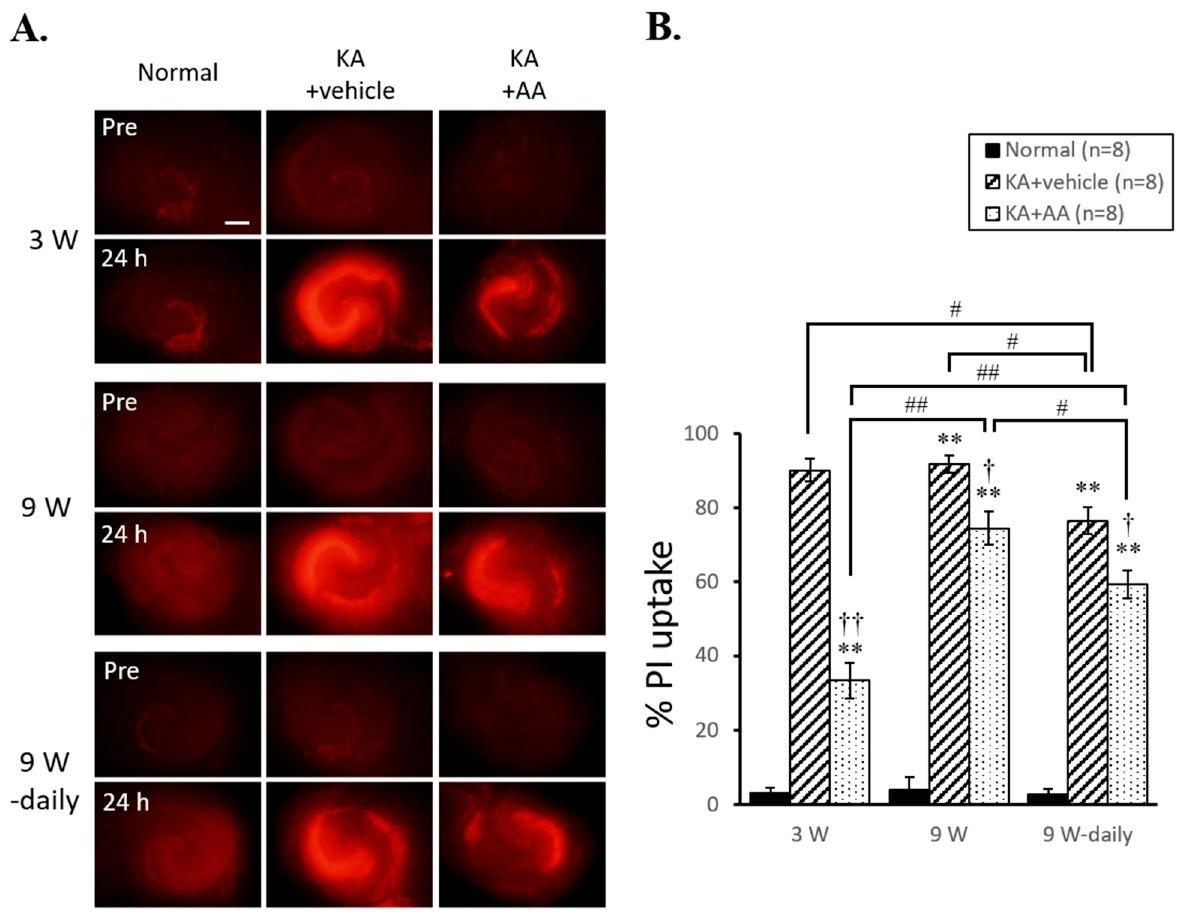
Figure 2. Neuroprotective effects of AA against KA-induced oxidative injury in hippocampal neurons. ( A ) Representative PI fluorescence images in OHSCs before (Pre) and 24 h after AA-treatment following oxidative injury. Representative images of PI uptake, as a marker of cell death, showed the effects of AA treatment at different time points. AA-only treatment (500 µM) showed no toxic effect in KA-untreated normal OHSCs (9 w-daily Normal). ( B ) KA treatment induced progressive cell death in the hippocampus compared to the normal group at each time point. After 24 h of AA treatment, PI signals in the CA3 area of the hippocampus were significantly reduced in the treated groups compared to no-treatment (vehicle) groups at each time point. After chronic AA treatment (9 w-daily), there was less cell death following the KA insult compared to the 9 w vehicle group, and the 9 w-daily AA treatment group also showed a significant decrease in the level of PI uptake compared to the 9 w AA treatment group. ** p < 0.01 compared to normal; † p < 0.05, †† p < 0.01 compared to vehicle; # p < 0.05, ## p < 0.01 comparing different time points: two-way ANOVA followed by Tukey’s post hoc comparison. Scale bar: 500 µm.